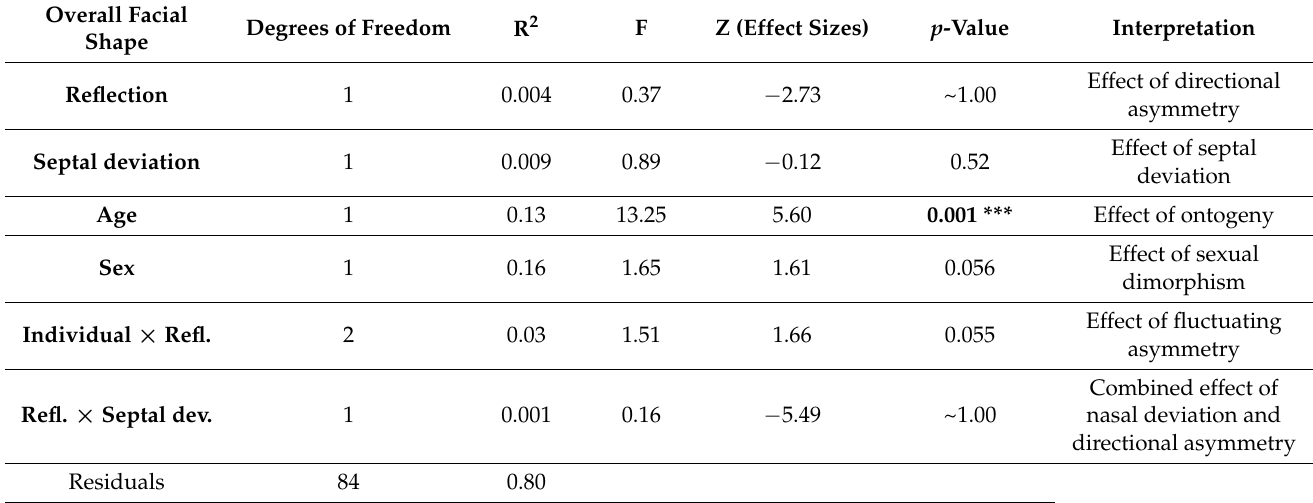
Table 7. Results of the Multivariate Procrustes ANOVA between the dependent variable of overall facial shape and the independent variables of reflection, septal deviation, age, sex, and the joint effect of individual × reflection and reflection x septal deviation. Asterisks indicate significance: * p